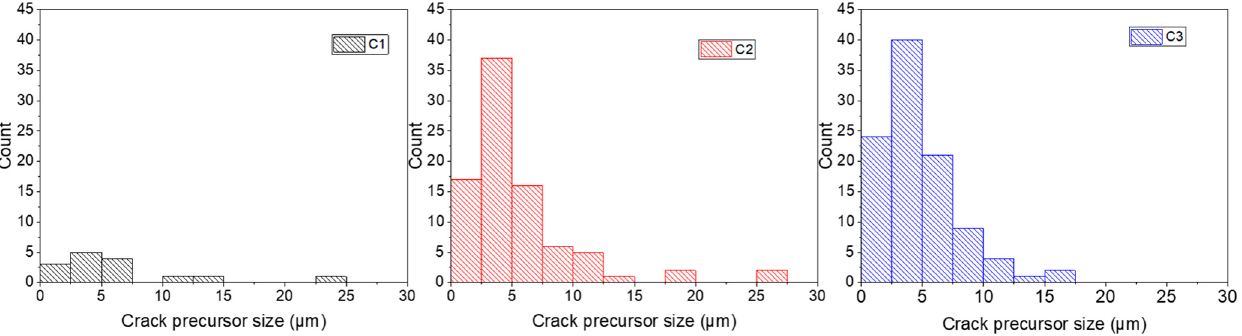
Figure 9. Distribution of crack precursor size observed on the different compounds subjected to 200% of local strain and 40% of N i .